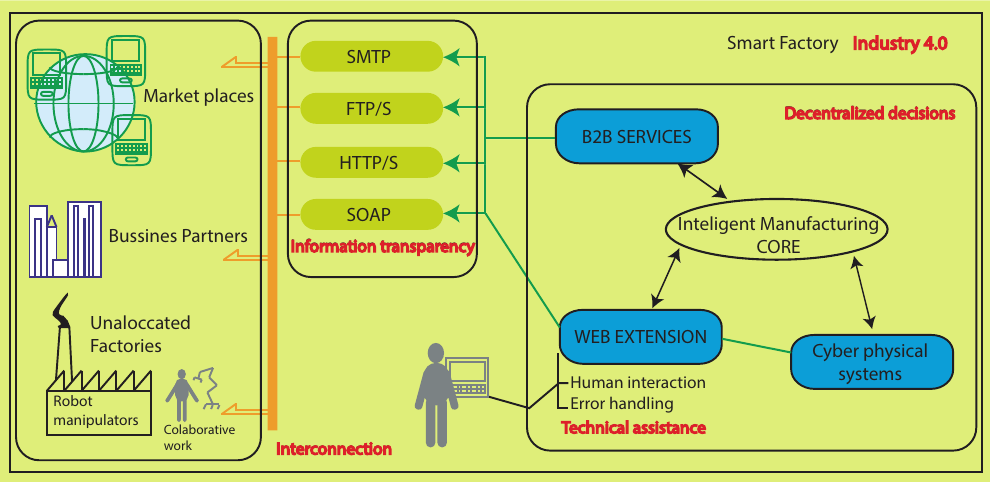
Figure 1. Principle scheme that shows the intervening agents in a process from a purchase, going through a decentralized decision-making until the unallocated